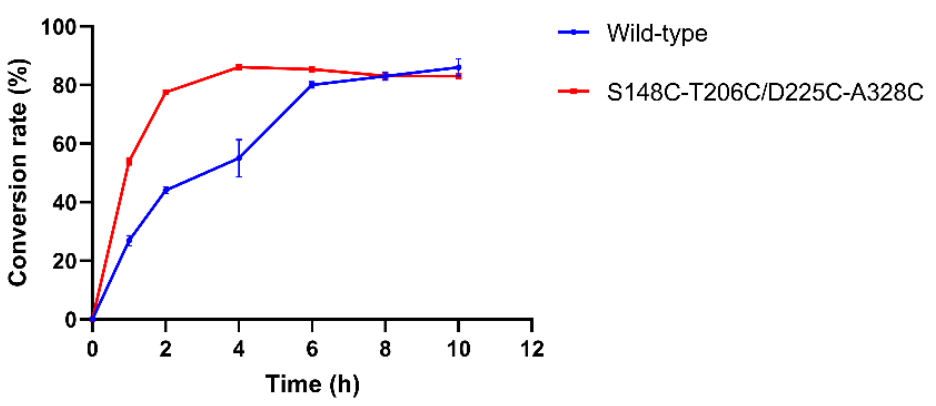
Figure 4. Time course of the production of PA from PC by wild-type MsPLD and mutant S148C- T206C/D225C-A328C.